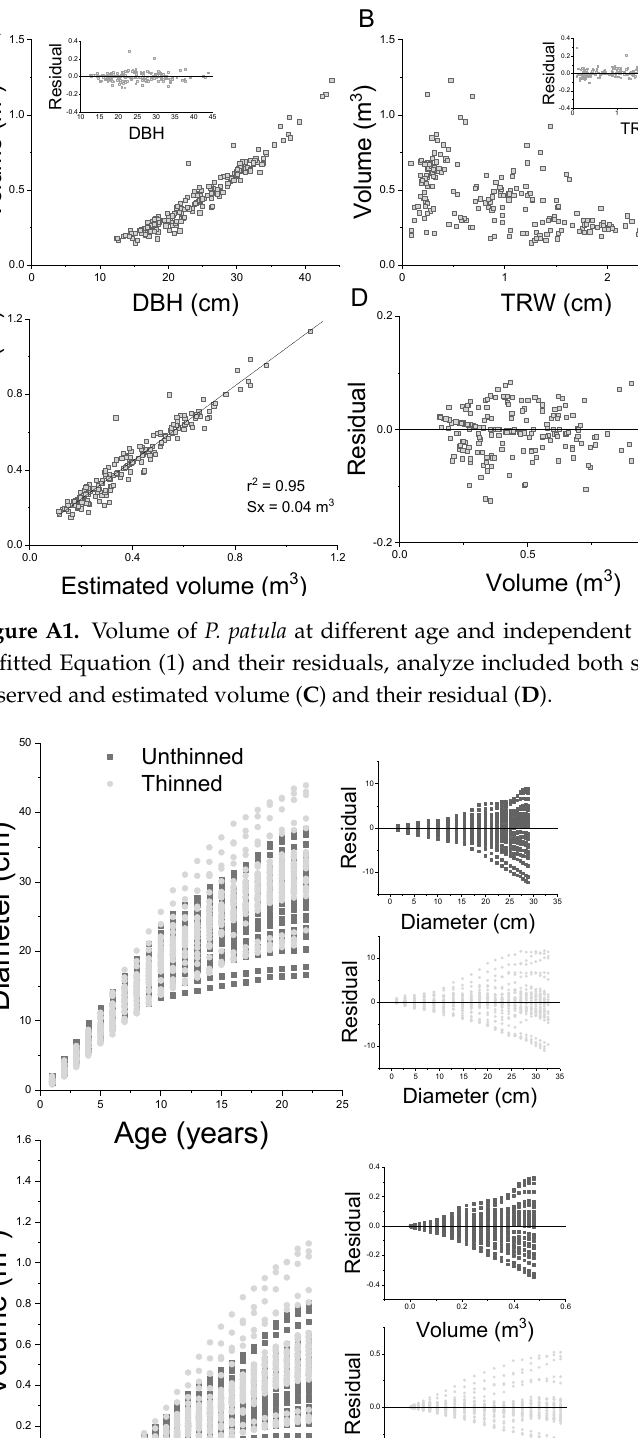
Figure A3. Residuals of cumulative DBH and wood volume of three growth class of P. patula trees fitted by Equation (2). Class 1 (C1): 15–24 cm; Class 2 (C2): 25–34 cm, Class 3 (C3): 35–45 cm.